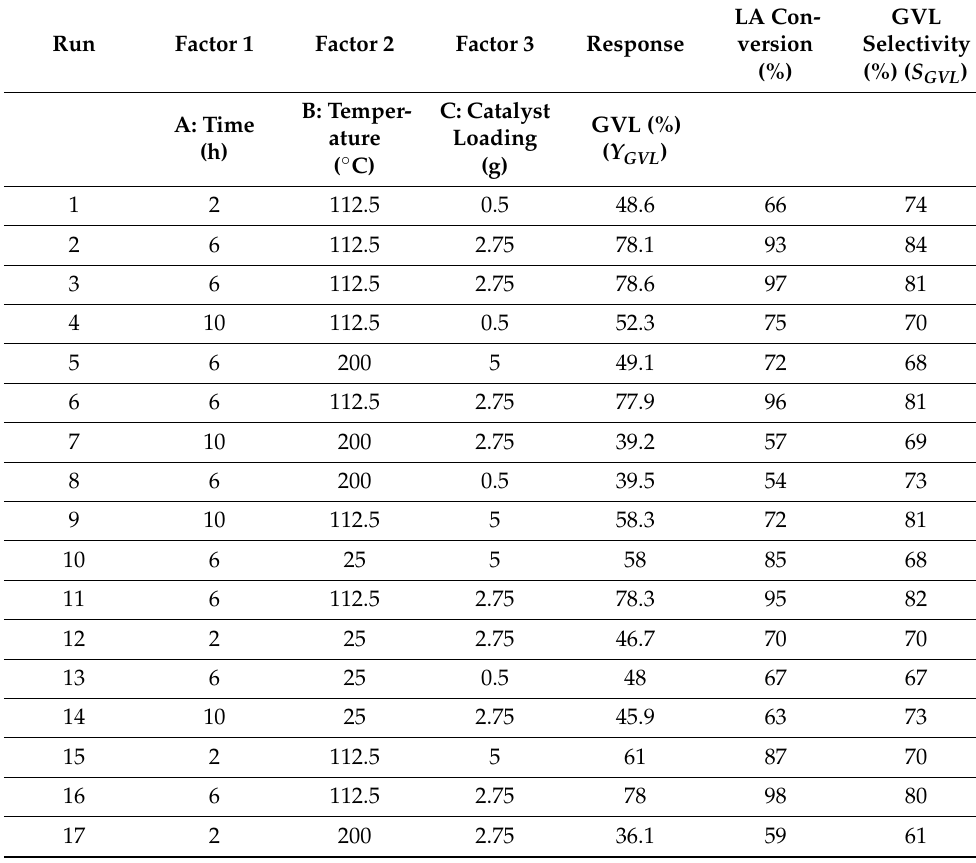
Table 2. Investigated reaction parameters with responses for GVL, LA conversions, and GVL